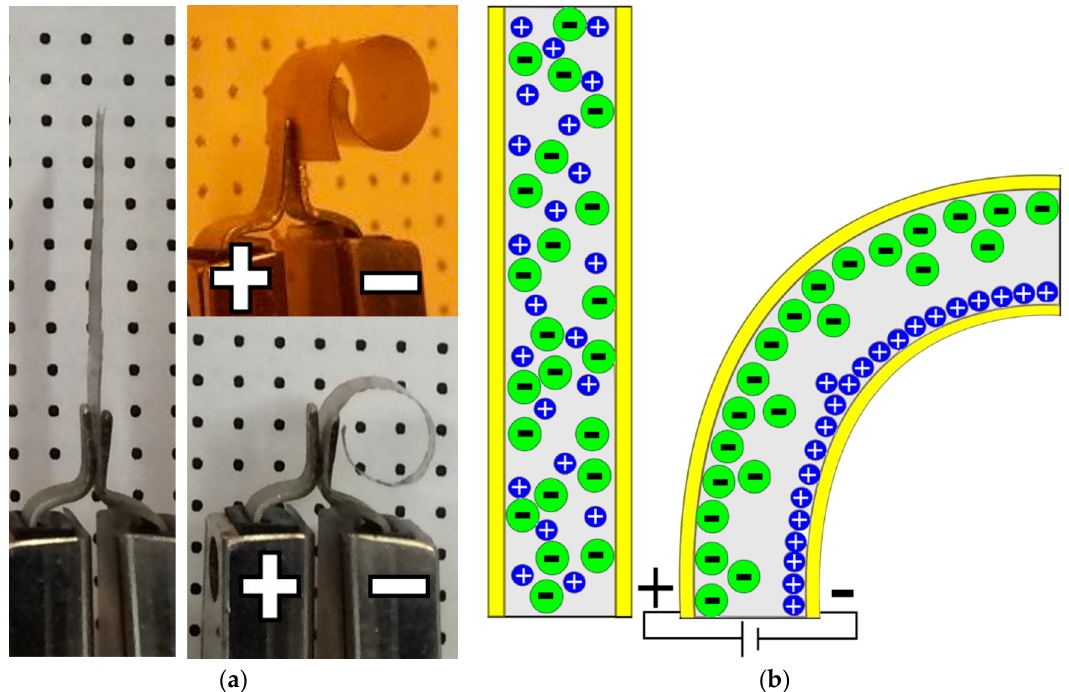
Figure 1. ( a ) Ionic polymer metallic composite (IPMC) sample before and after electric excitation; ( b ) representation of IPMC bending actuation mechanism where the initial randomly oriented ions (Li + and ClO 4 − ) in the poly(ethylene oxide) (PEO) matrix are attracted towards and traverse to their respective electrodes when an external voltage is applied.